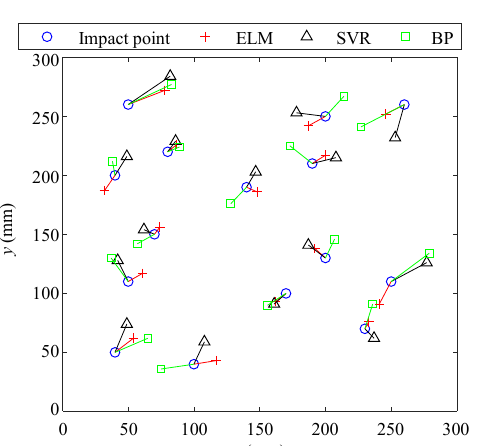
Fig. 10 Impact localization results. Fig. 11 Impact localization